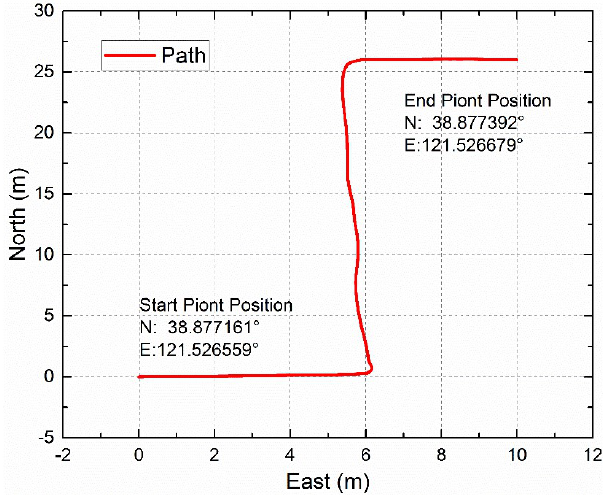
Figure 27. Outdoor path offered by the inertial navigation system.